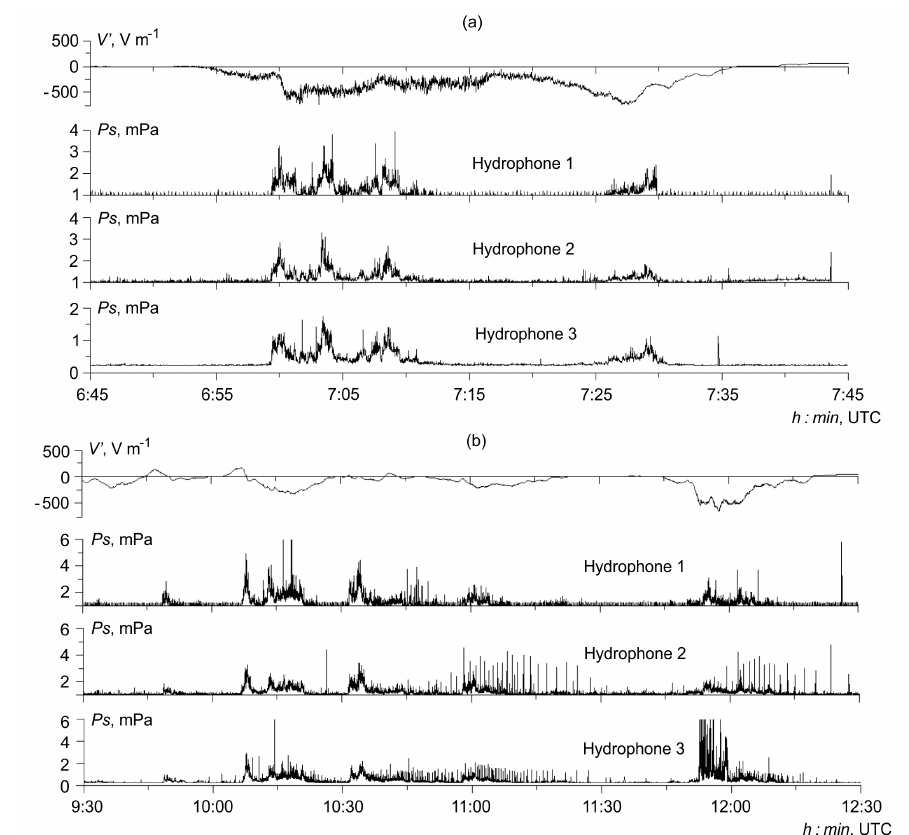
Figure 9. Developed views of the first ( a ) and the second ( b ) record fragments of atmospheric potential gradient V (cid:48) and acoustic pressure P s at three measurement points from Figure